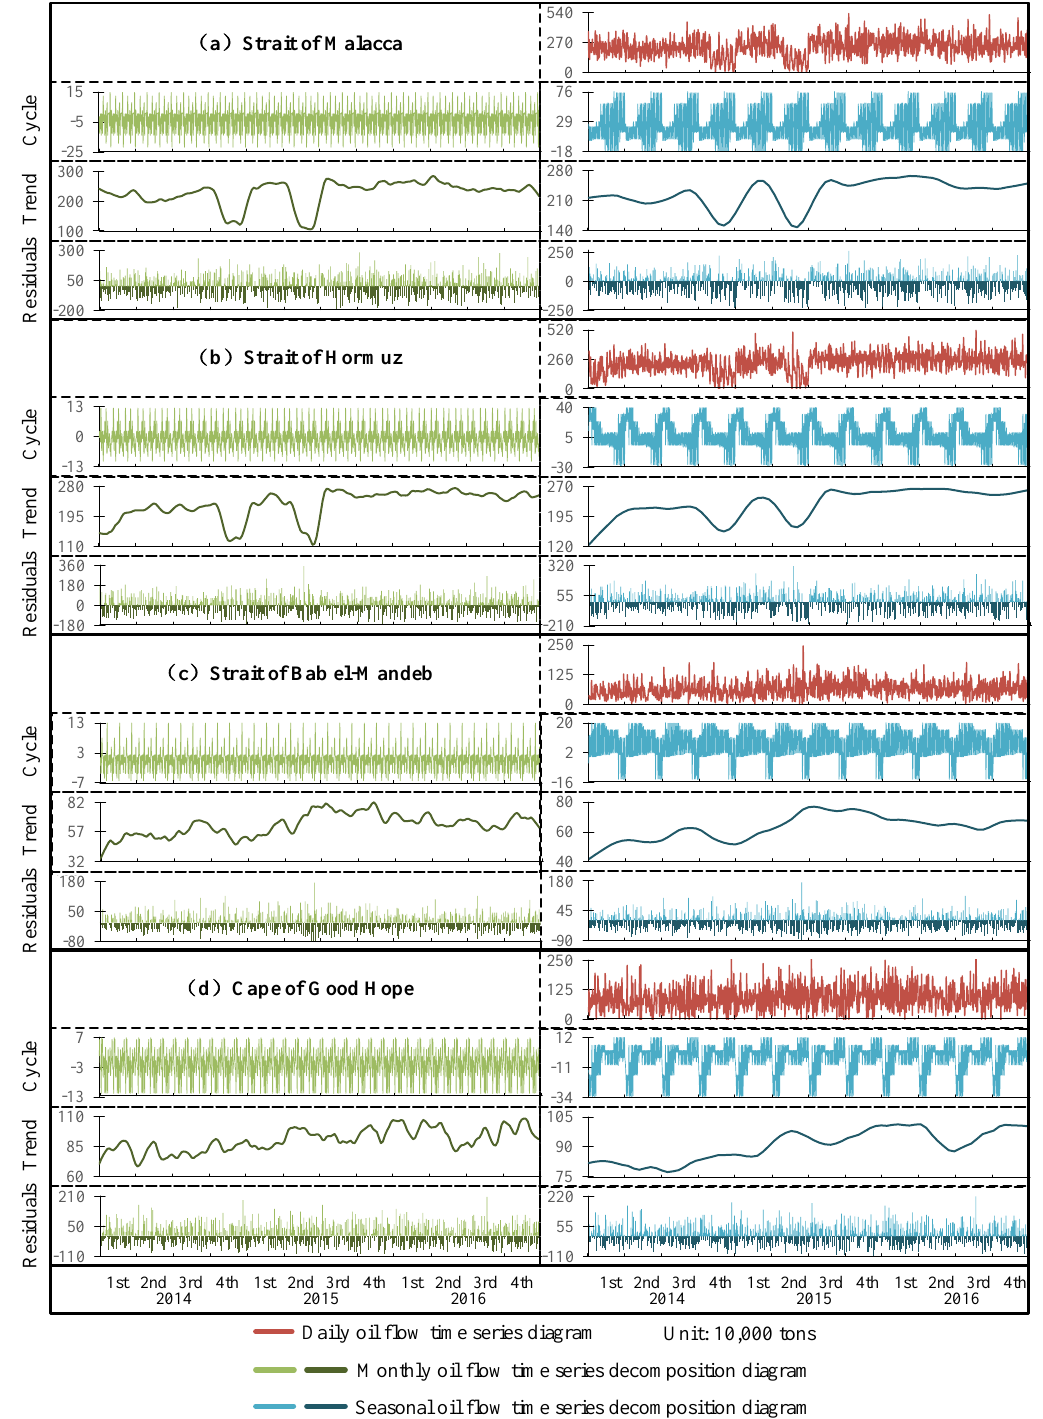
Figure 9. Daily oil flow time series diagram and the monthly and seasonal oil flow time series decomposition diagram in the four MOCs.